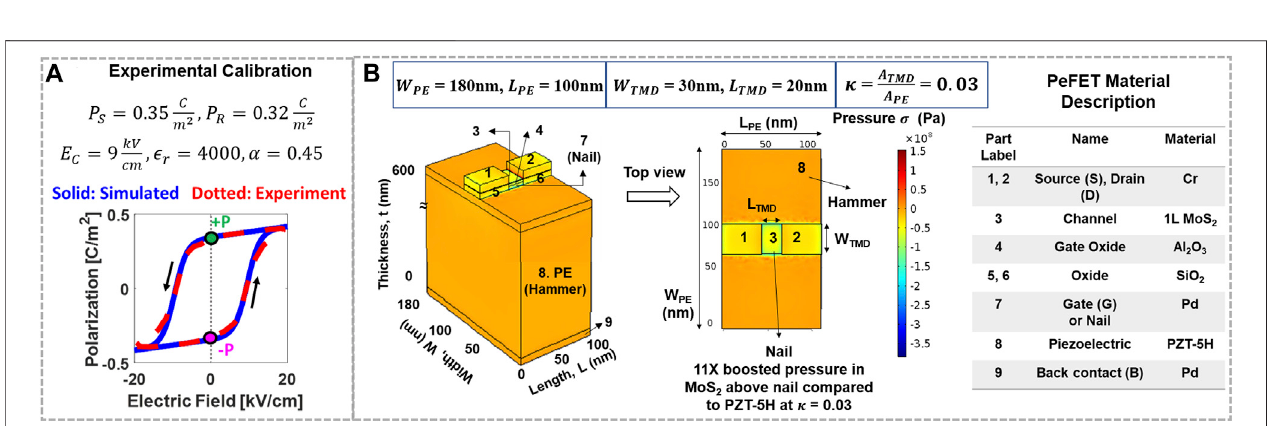
FIGURE 4 | (A) Calibration of simulated polarization-electrical response with experiments. (B) 3D COMSOL model of PeFET with components labeled, their materialspeci fi